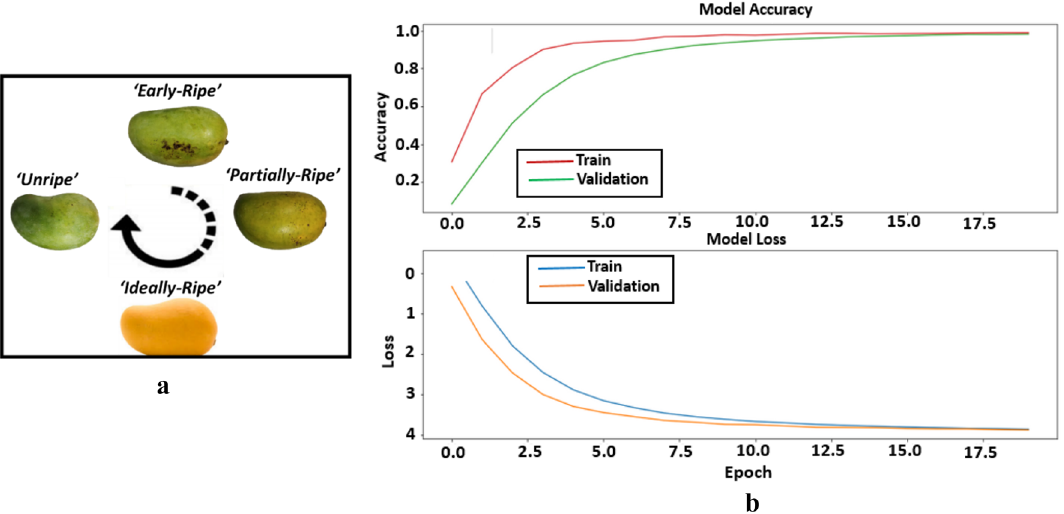
Fig. 5 a Pictorial Representation of ripeness level of ‘Kesar’ cultivar of mangoes, b classification accuracy of ripeness level of mangoes on using ‘VGG-16’